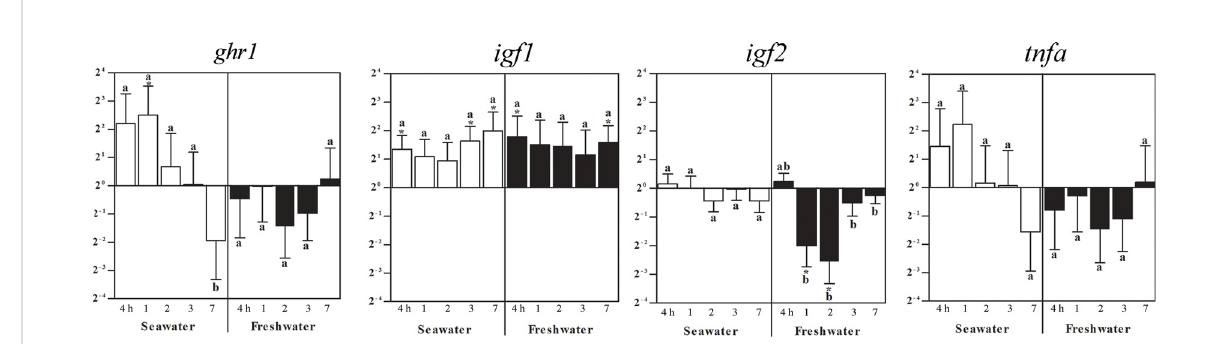
FIGURE 5 Effects of a seawater and freshwater exposure on the head kidney ghr1 , igf1 , igf2, and tnfa gene expressions. Relative changes (log 2 , y-axis) of mRNA expression at 4 h, 1, 2, 3 and 7 days (x-axis) after exposure to seawater (white columns) and freshwater (black columns). Bars represent mean ratios between treated and control group ± SEM and asterisks show signi fi cant differences: * p < 0.05; *** p< 0.0005. Bars within treatment groups that do not share any letters are signi fi cantly different from each other: p < 0.05, e.g., ghr1 seawater expression between 4 hours, 1, 2 or 3 days and 7 days are signi fi cantly different, but between 4 h and 1 day, 2 or 3 days are not signi fi cantly different.